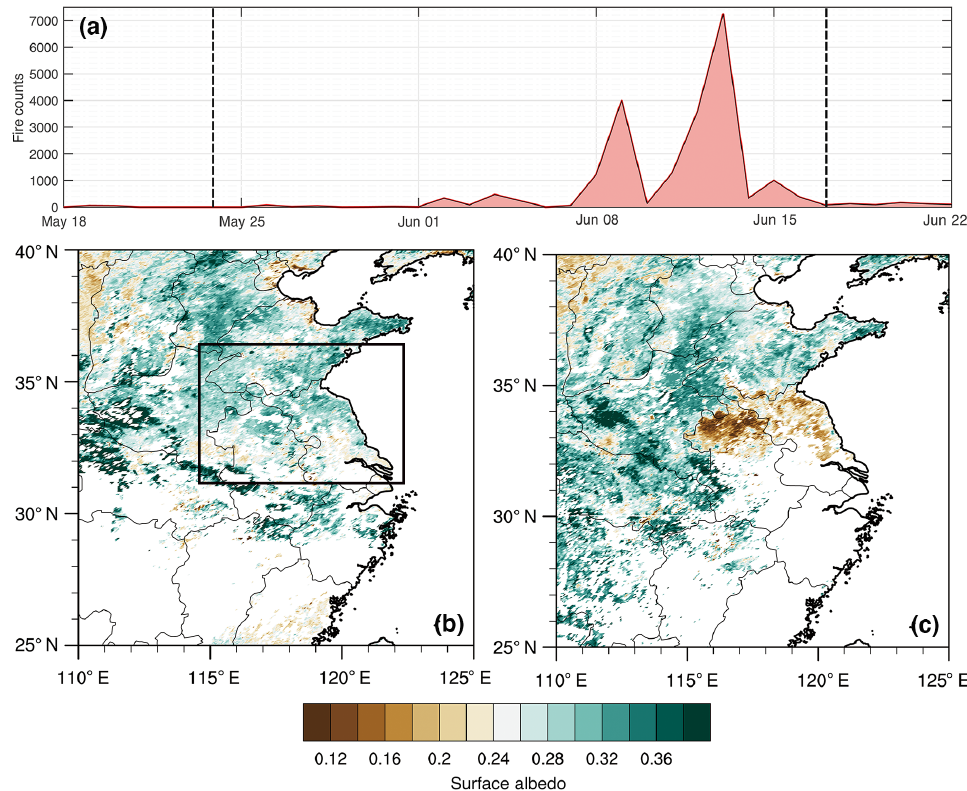
Figure 1. (a) Daily number of satellite fire counts in the black-boxed zone marked in panel (b) . Distribution of satellite-retrieved surface albedo in the northern part of Anhui and Jiangsu provinces (b) on 24 May and (c) on 17 June in 2012. Note that the two dates are marked by black dashed lines in panel (a)